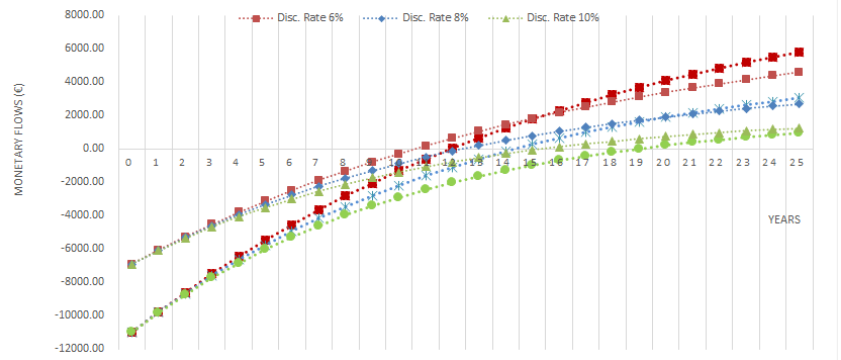
Figure 16. Monetary flows with different discount rates for only Etanorm 32-160 installed (top lines) and for both PATs installed (bottom lines).